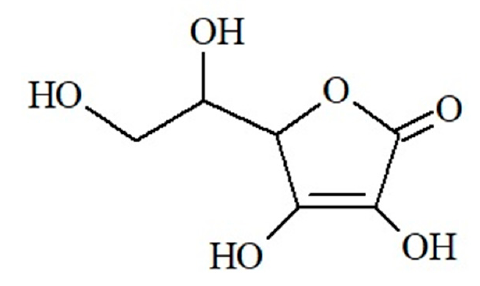
Figure 3. Chemical structure of ascorbic acid (own work).